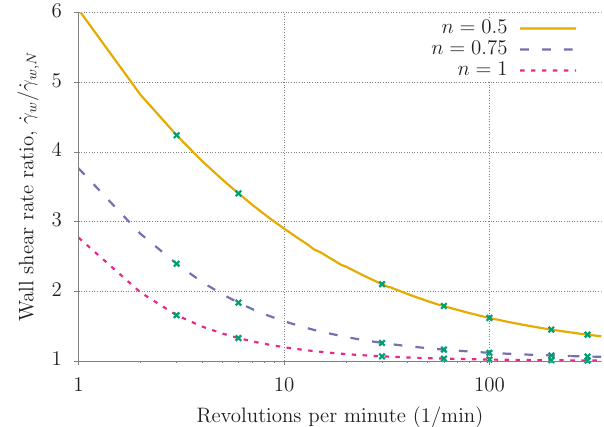
Figure 4: Ratio of actual (Herschel-Bulkley) wall shear rate to the Newtonian shear rate in a Fann Model 35 R1-B1 geometry. We as- sume a fluid with τ y = 5 Pa, k = 0.1 Pa · s n and vary n .